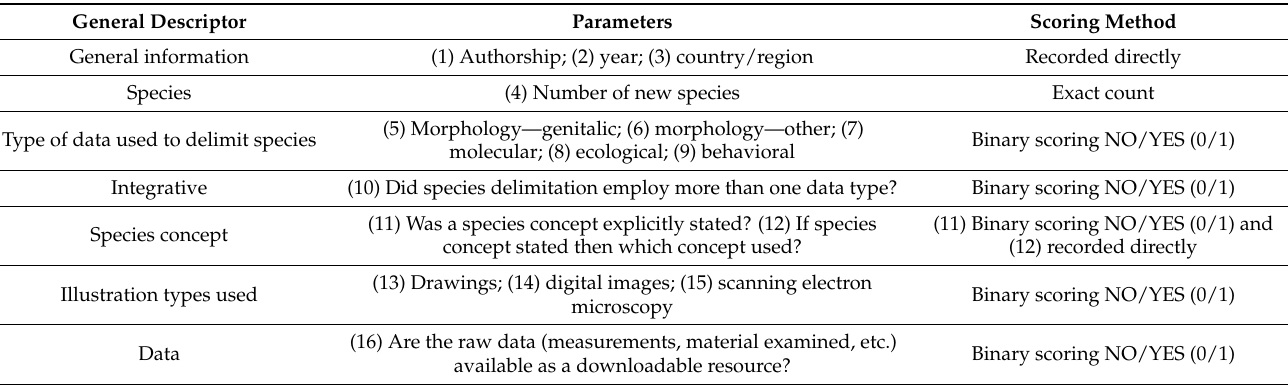
Table 1. Parameters evaluated and how they were